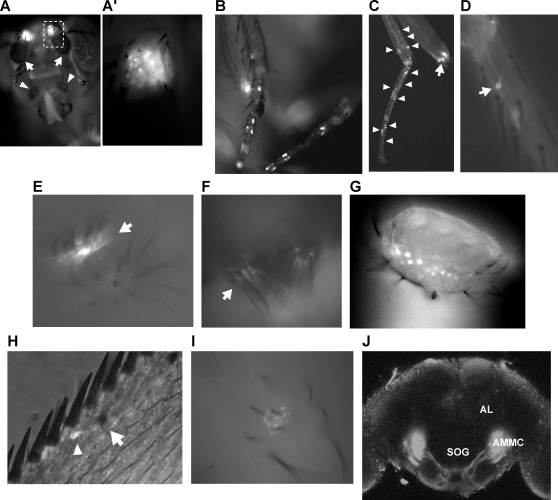
Expression pattern of Gr68a-GAL4.(A) External appearance of the GFP expression on a head. Arrows and arrowheads indicate antennal third segment and maxillary palps respectively. (A′) Close-up of the second segment of the antenna. (B) Male forelegs. (C) Female foreleg. (D) Close-up of a male midleg. A cell body (arrowhead) is marked by GFP at base of mechanosensory bristle (arrow). (E) Root of male clasper teeth on the genitalia (arrow) and (F) male anal plate (arrow). (G) Tip of proboscis. (H) Root (arrowhead) of chemosensory bristles (arrow) of the wing margin. (I) Ventral view of female abdomen. (J) Frontal view of a dissected brain, showing antennal lobe (AL), suboesophageal ganglion (SOG), antennal mechanosensory and motor center (AMMC) and optic lobe (OL).